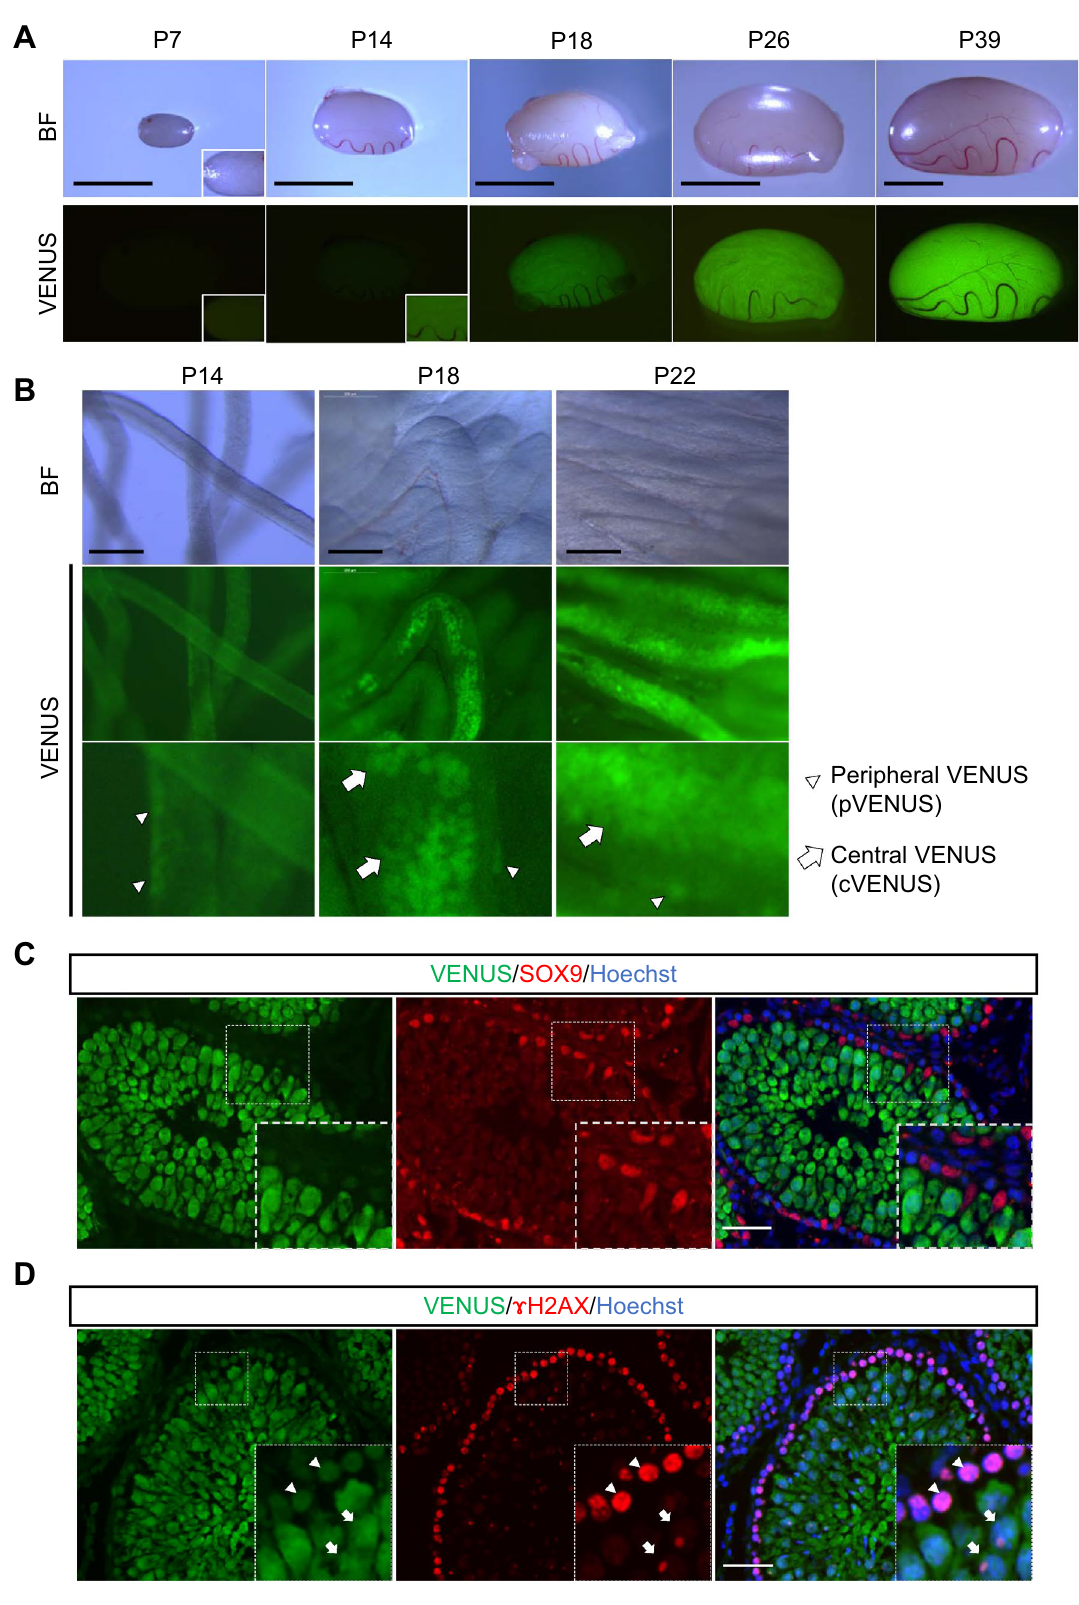
Figure 1. Characterization of Haspin -Venus Tg rats. ( A ) Testis of HV-Tg rats at age P7 to P39. Blight field pictures and Venus fluorescence under excitation light are shown. Scale bar; 5 mm. ( B ) Higher magnified view of HV-Tg rat testis. White arrowheads and arrows indicate pVenus and cVenus, respectivly. Scale bar; 0.2 mm. ( C ) Immunohistochemistry to Venus and SOX9, a marker of Sertoli cells, with Hoechst nuclear stain was performed on testis of rat P35. Venus stain was specific to germ cells, not appeared in Sertoli cells. Scale bar; 50 µm. ( D ) Immunohistochemistry to Venus and γH2AX with Hoechst stain was shown. White arrowheads indicate leptotene/zygotene spermatocytes with weaker Venus expression. White arrows indicate pachytene spermatocytes with stronger Venus expression. Scale bar; 50